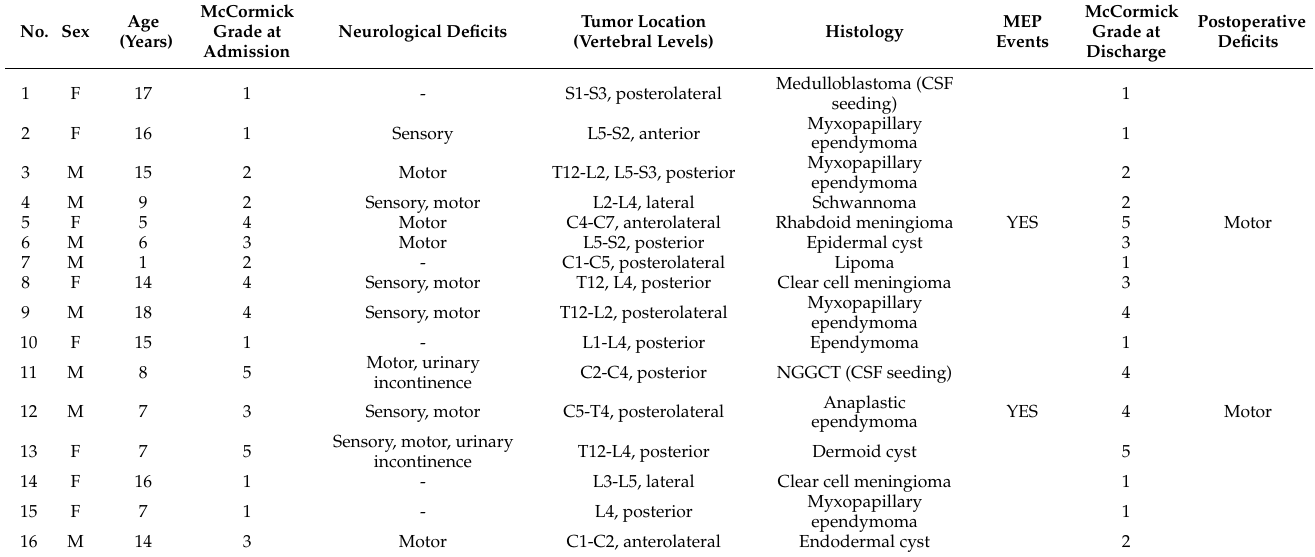
Table 1. Characteristics of the pediatric patients presenting with IDEM